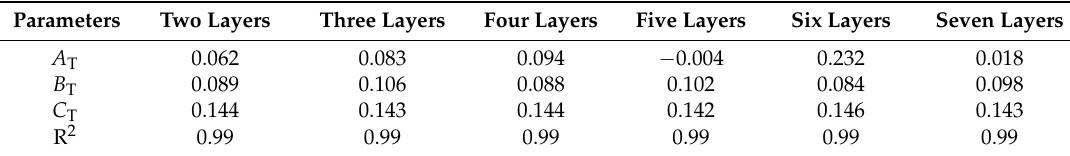
Figure 10. Absolute value of interface steady state charge density with different temperatures (15 kV/mm). Table 4. Fitting parameters for charge density at steady state (1800 s) under different temperatures for multi-layer oil-paper insulation.